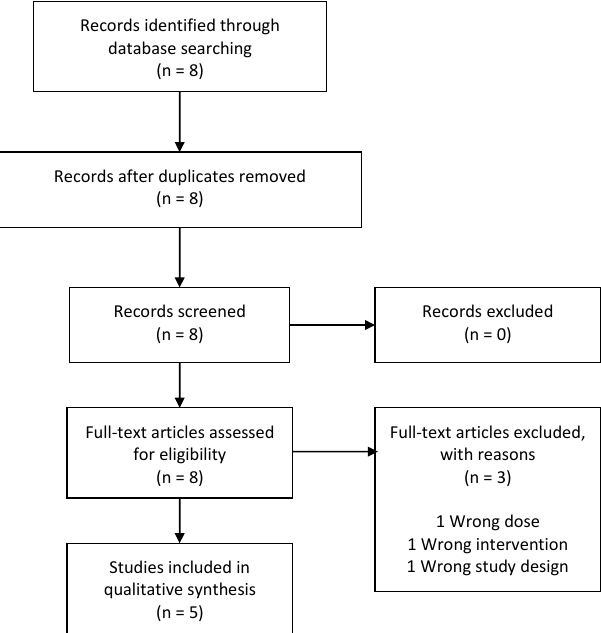
Figure 2. Flowchart of secondary studies identified in reviews.